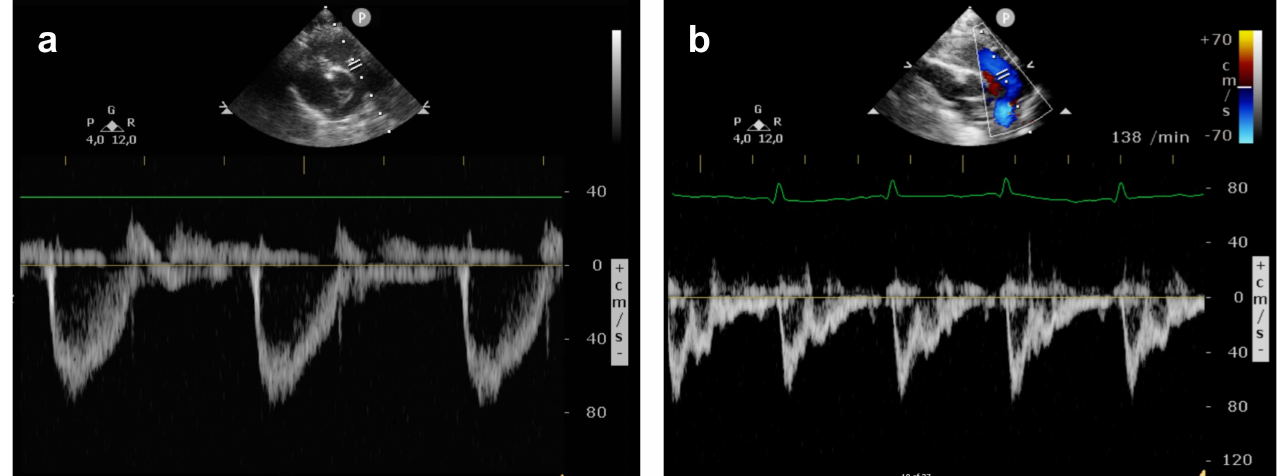
Figure 1. Pulmonary artery flow pattern on the first day of life: ( a ) normal pulmonary artery flow in a healthy neonate showing a PAAT:ET of 0.335; ( b ) pulmonary artery flow in a CDH neonate with severe pulmonary hypertension and a PAAT:ET of